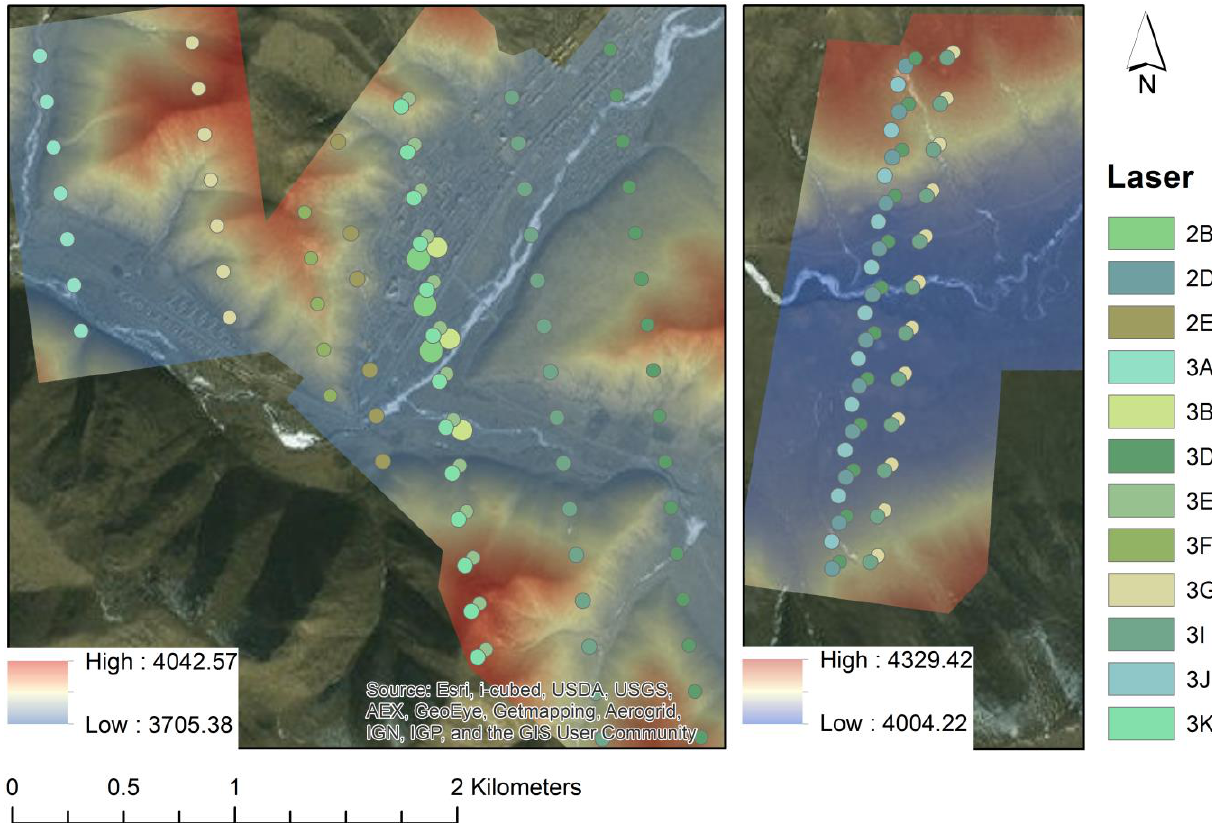
Figure 2. Study area with digital elevation models derived by UAV data (blue-red), geolocations of GLAS footprints and the corresponding laser campaign (2A – 3K) (Background image source: ESRI, i-cubed, USGS, AEX, GeoEye, Getmapping, Aerogrid, IGN, IGP, and the GIS User